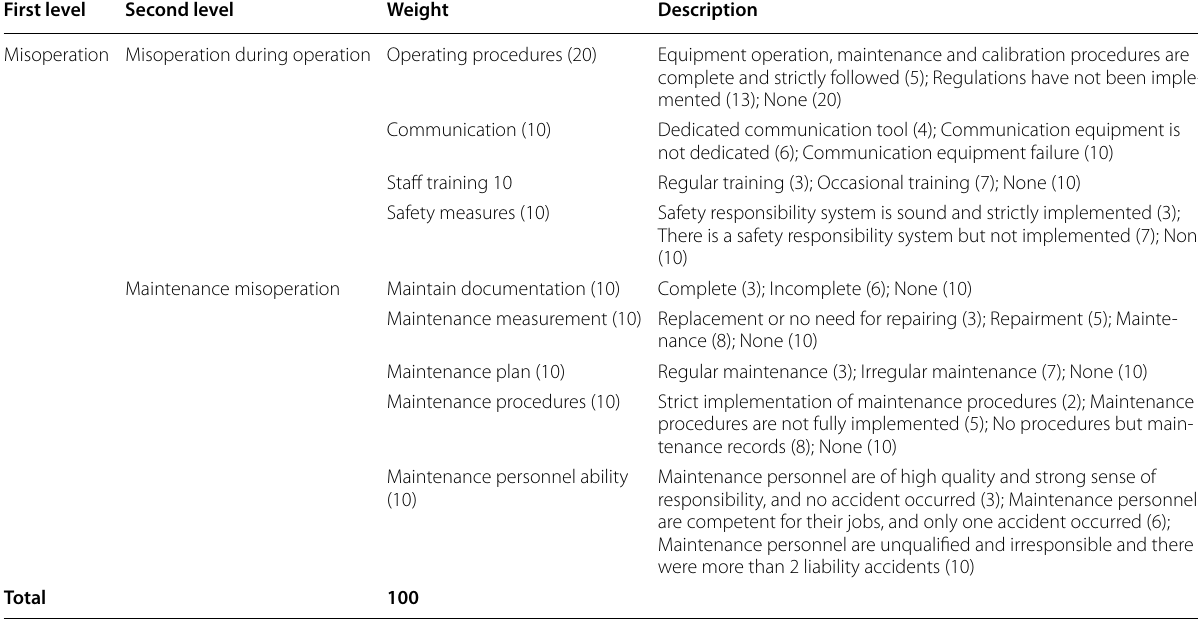
Table 5 Failure factors of gathering pipelines regarding misoperation First